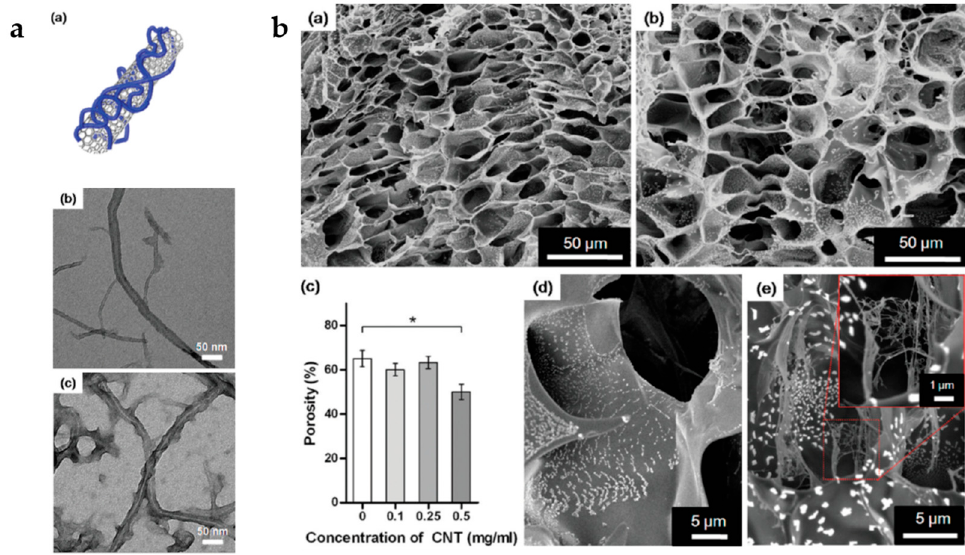
Figure 6. ( a ) CNT-gelatin methacrylate (GelMA) hybrids: (a) Schematic diagram of a GelMA-coated CNT and the respective high resolution transmission electron microscopy images of bare CNTs (b) and GelMA coated CNTs (c); ( b ) Scanning electron images of cross sections of GelMA (a) and CNT GelMA (b) hydrogels with 0.5 mg/mL CNTs; (c) CNT-GelMA hydrogels porosity with different concentrations of CNTs (* p < 0.05); Magnified images show parts of a cross section of (d) GelMA and (e) CNT GelMA hydrogel with nanofiber junctions inside a porous structure. (Reprinted with permission from [152]. Copyright 2012 American Chemical Society).